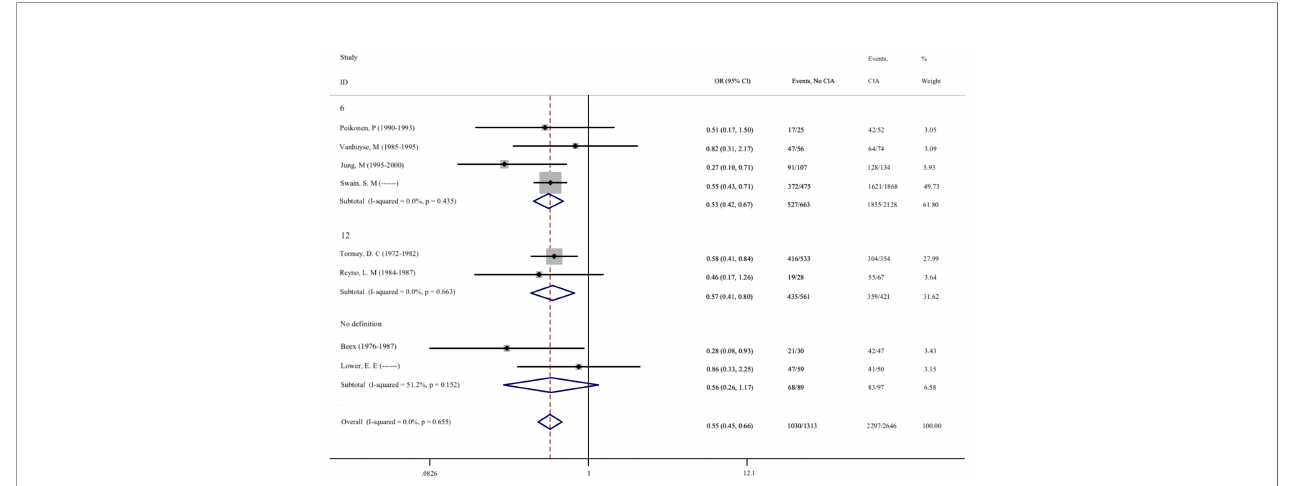
FIGURE 6 | No CIA versus CIA on OS in premenopausal breast cancer patients.